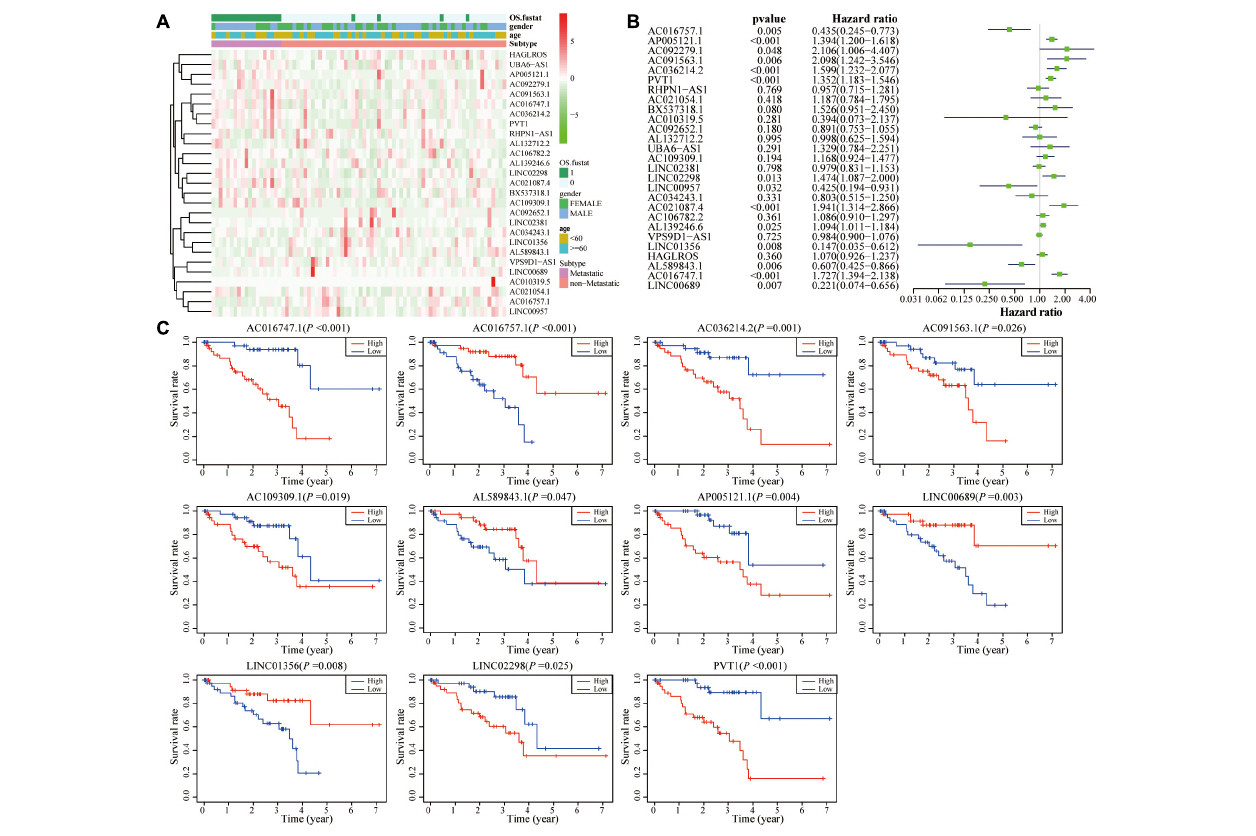
FIGURE 4 | Identification of autophagy-related lncRNAs in UM. (A) Heat map of the autophagy-related lncRNAs and their correlation with clinical characteristics. (B) Univariate Cox regression analysis results show that 14 autophagy-related lncRNAs correlate with overall survival of UM patients. (C) Kaplan–Meier survival curve analysis shows that 11 autophagy-related lncRNAs correlated with overall survival of UM